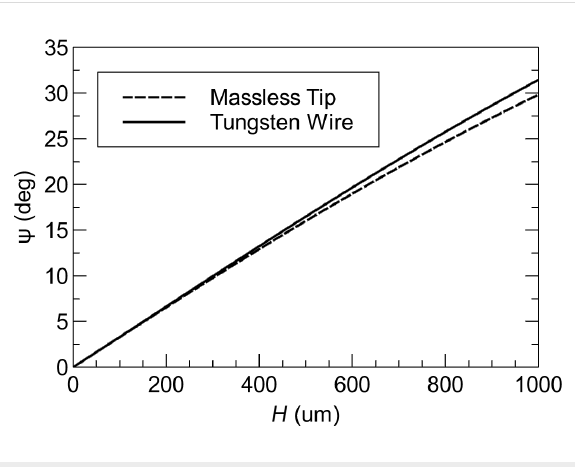
Figure 3: Tip displacement angle ψ vs tip height H calculated for the tungsten wire tip described in Table 1 and a hypothetical massless tip. B = 0 for both cases. The agreement between the two curves shows that ψ primarily depends on the tip